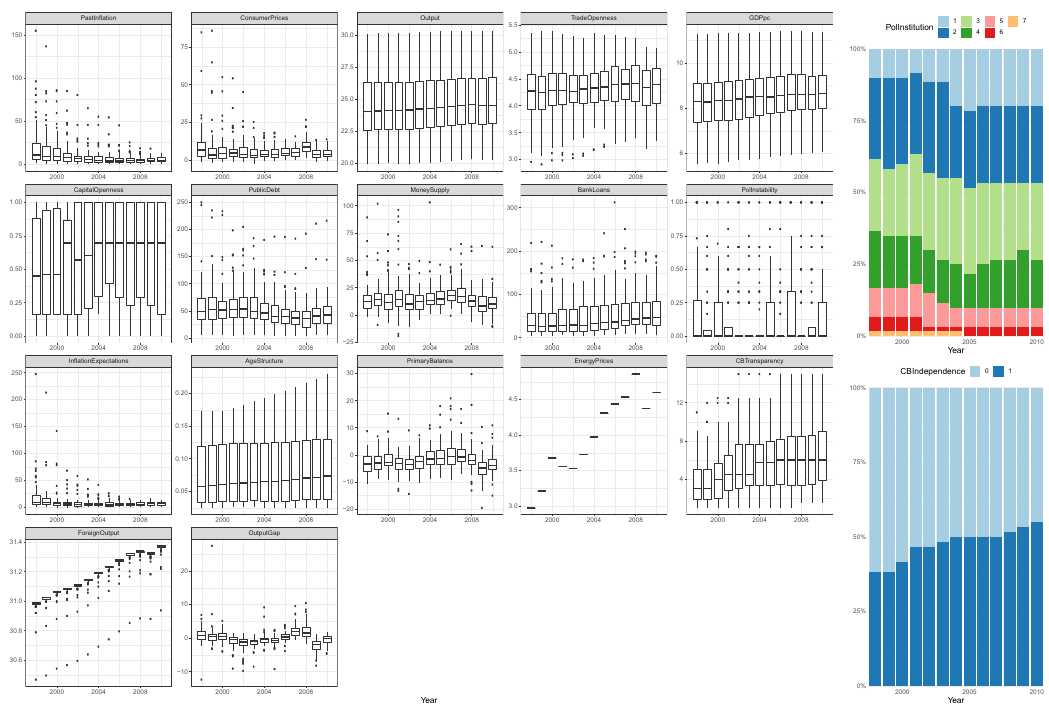
Figure 7: Summary statistics for all variables included in the data analysis. The variables “ Output, ” “ TradeOpenness, ” “ GDPpc, ” “ EnergyPrices, ” and “ ForeignOutput ” were transformed by the natural logarithm for better readability. Appendix A gives more details on the variables and what they measure.